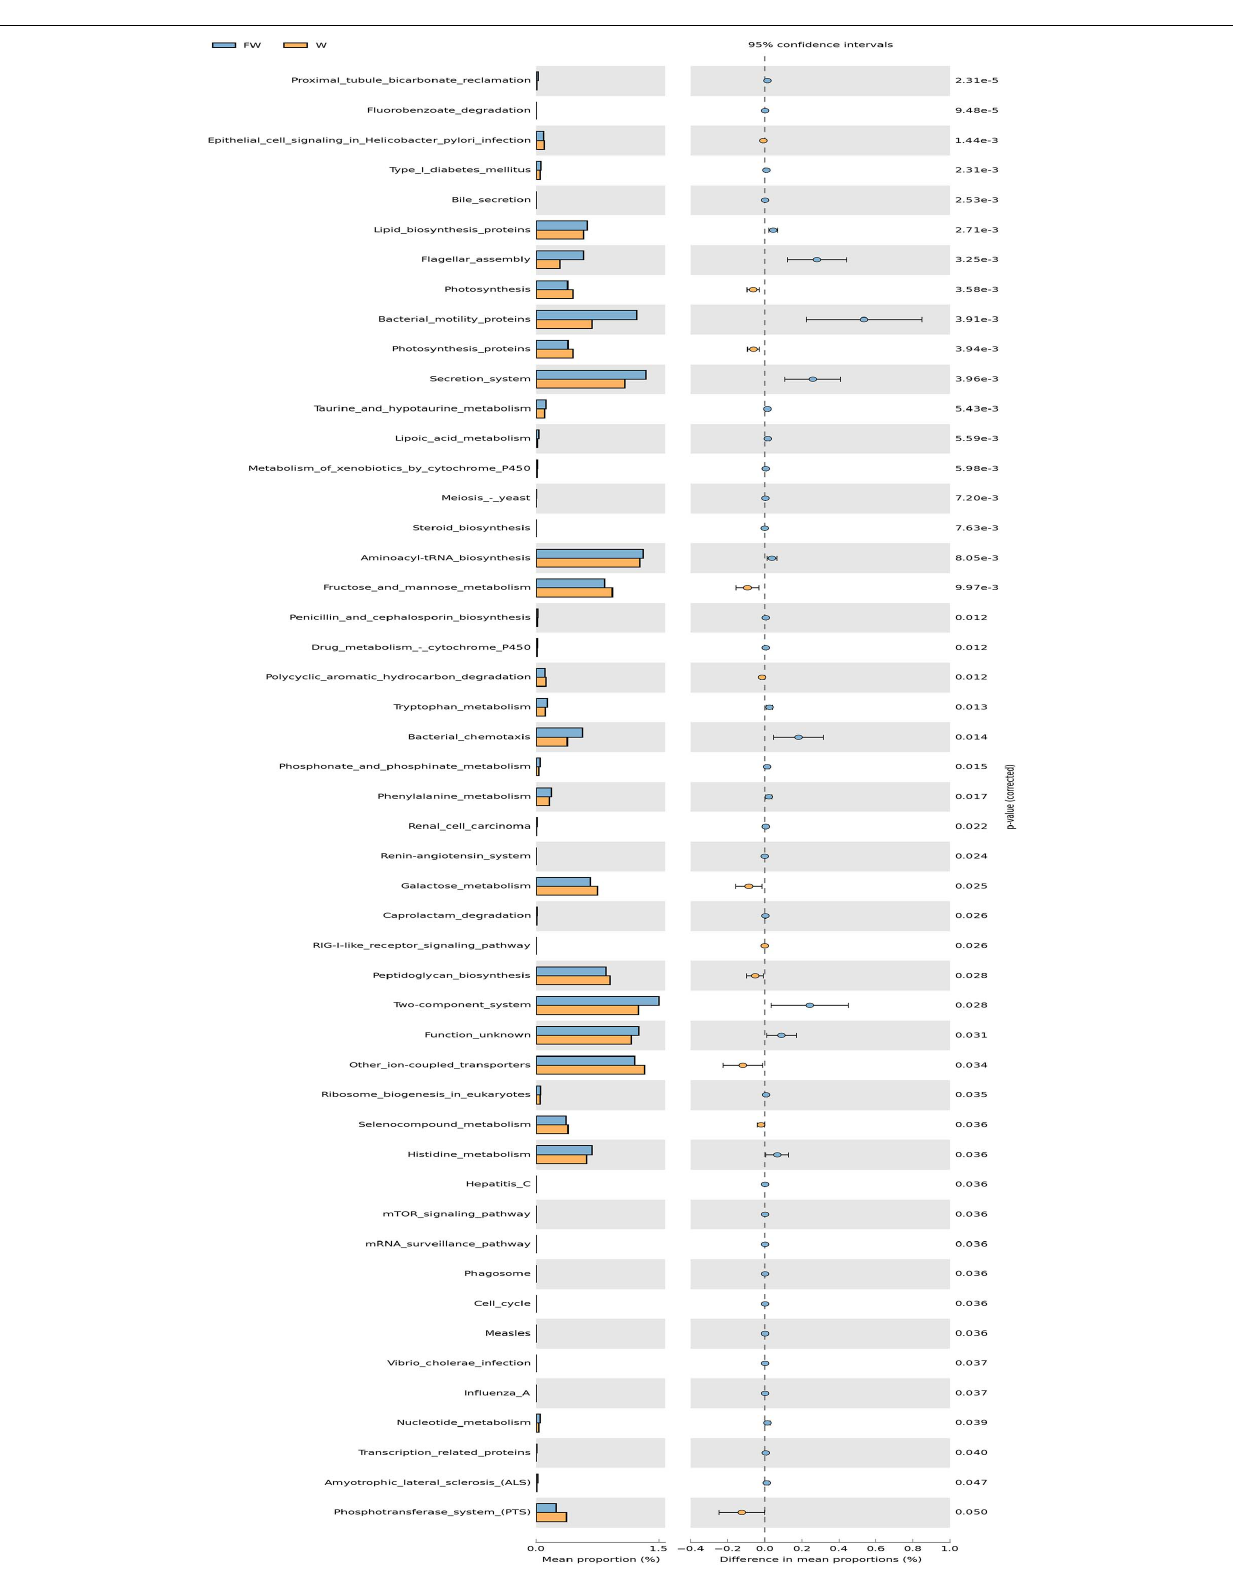
Frontiers in Microbiology |